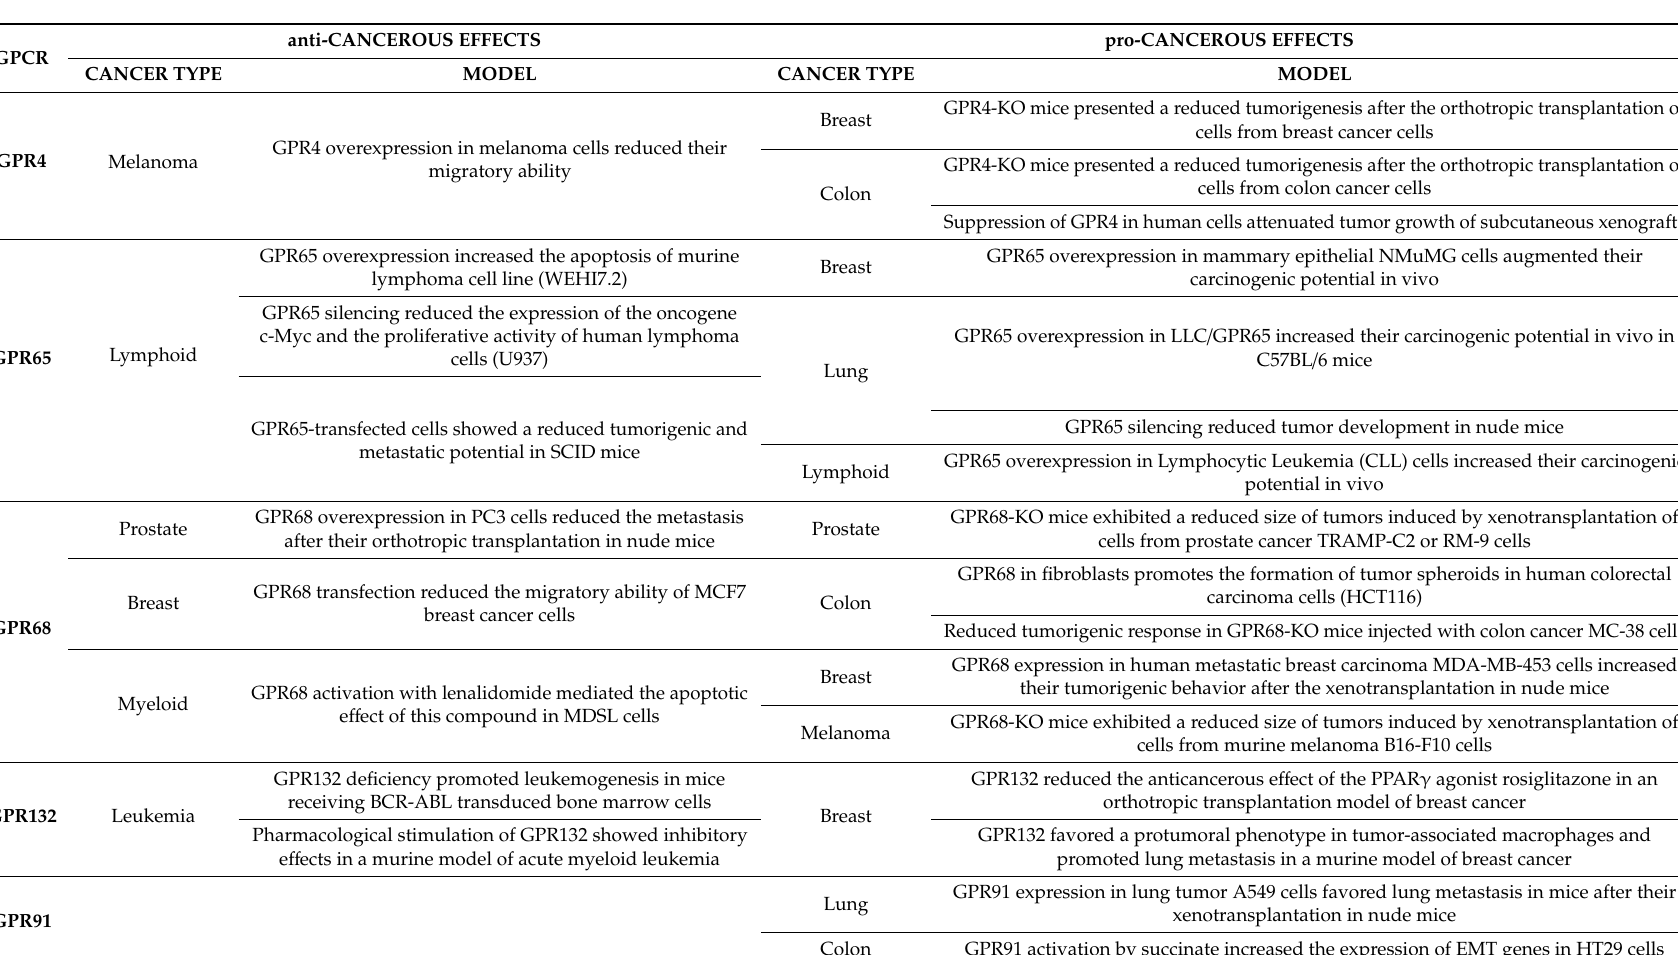
Table 6. Functional studies performed describing the role of pH-sensitive and citric acid cycle intermediates-sensitive receptors in several types of cancers. This table includes the literature which demonstrates the anti-cancerous and pro-cancerous role of each pH-Sensitive and citric acid cycle intermediates-sensitive receptor in both in vitro cells or in vivo with